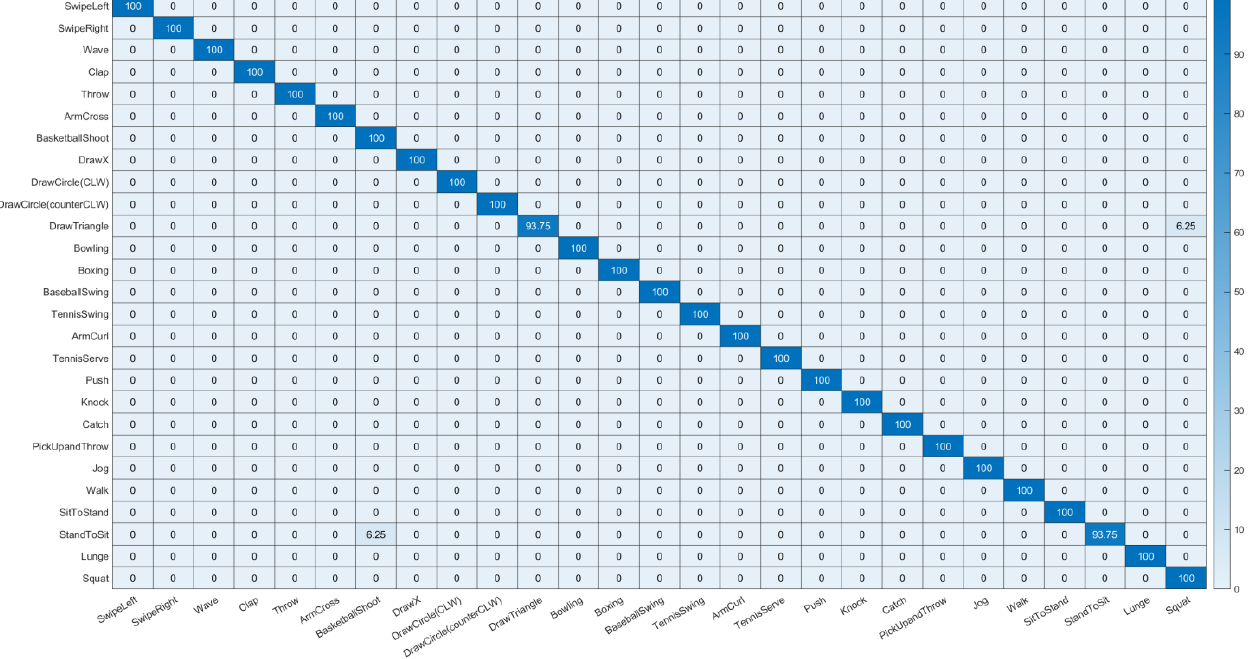
Figure 9. Confusion chart for UTD-MHAD dataset using joints + velocity + CCA.